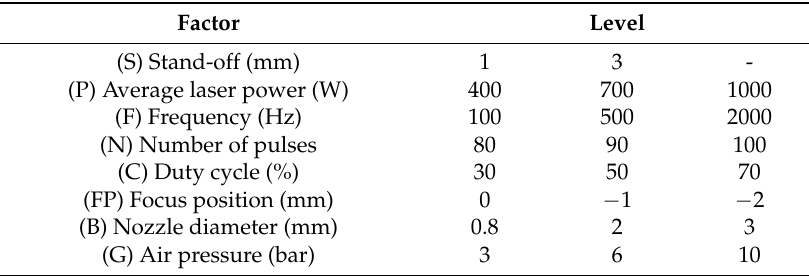
Table 3. Factors and levels corresponding to the L8 orthogonal array (a focus position of 0 mm corresponds with the focal spot on the surface of the slate tile; negative values refer to positions underneath the surface).